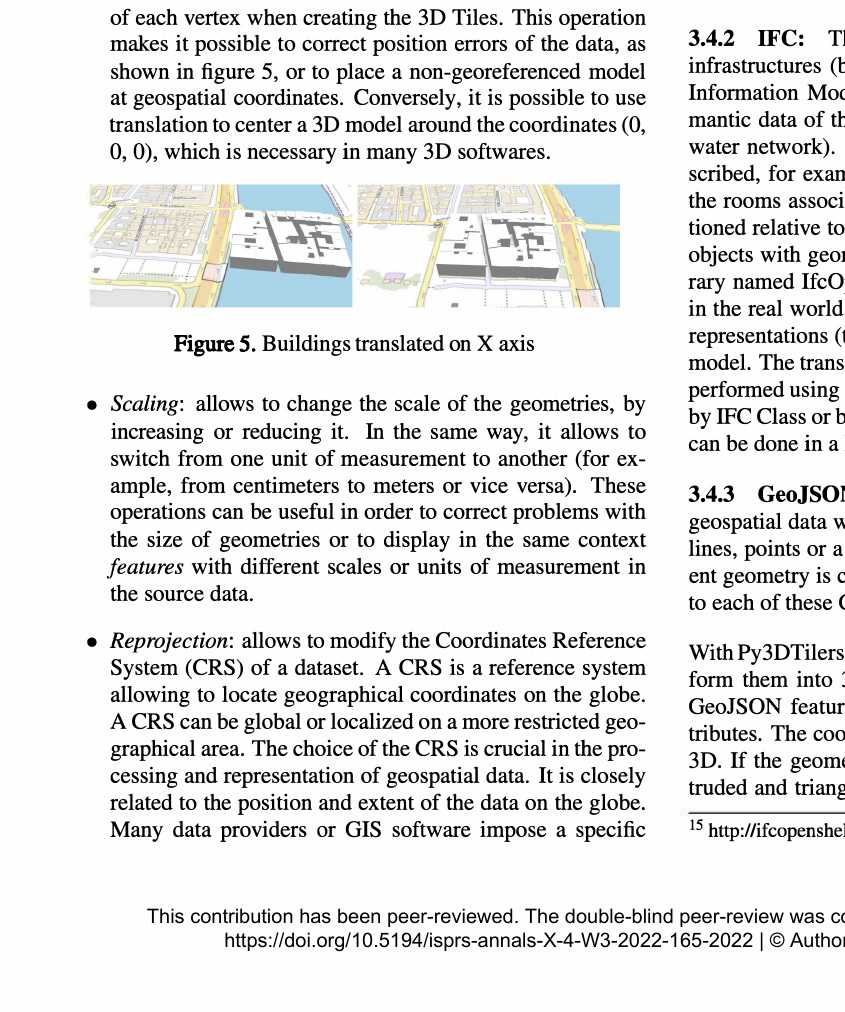
Figure 5. Buildings translated on X